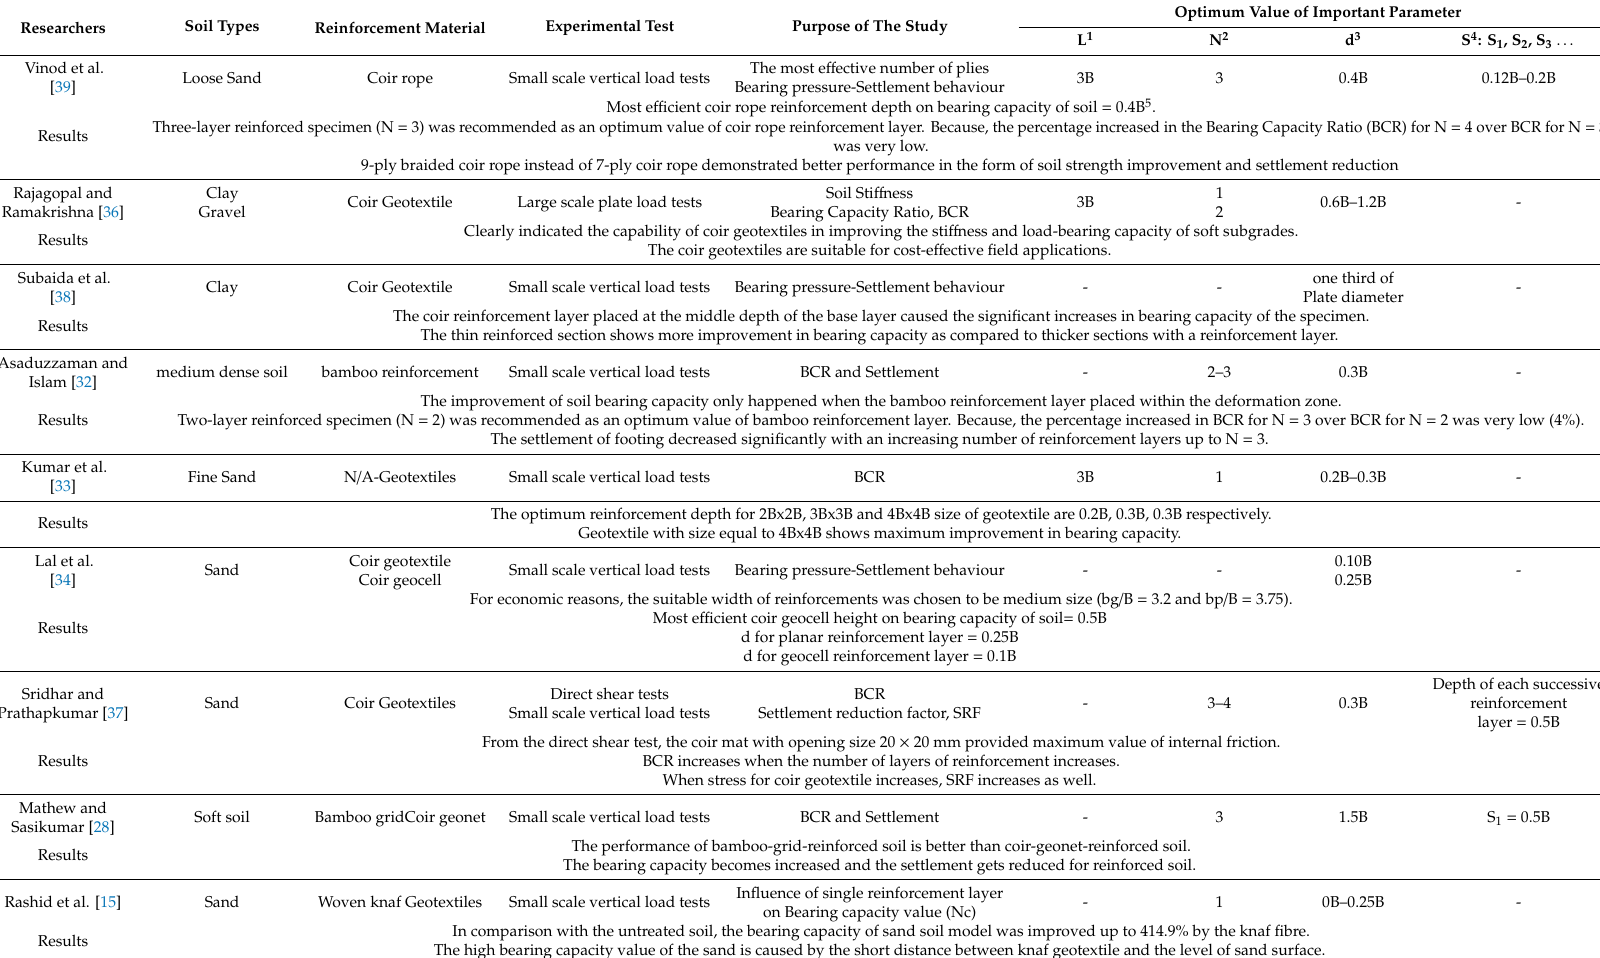
Table 4. Summary of the previous research on the ground improvement using a reinforcement